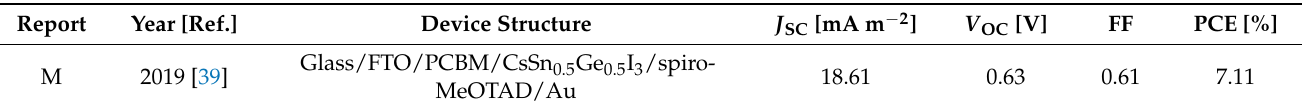
Table 6. Record table containing the reported Sn-PSCs and the corresponding photovoltaic parameters mentioned in Section